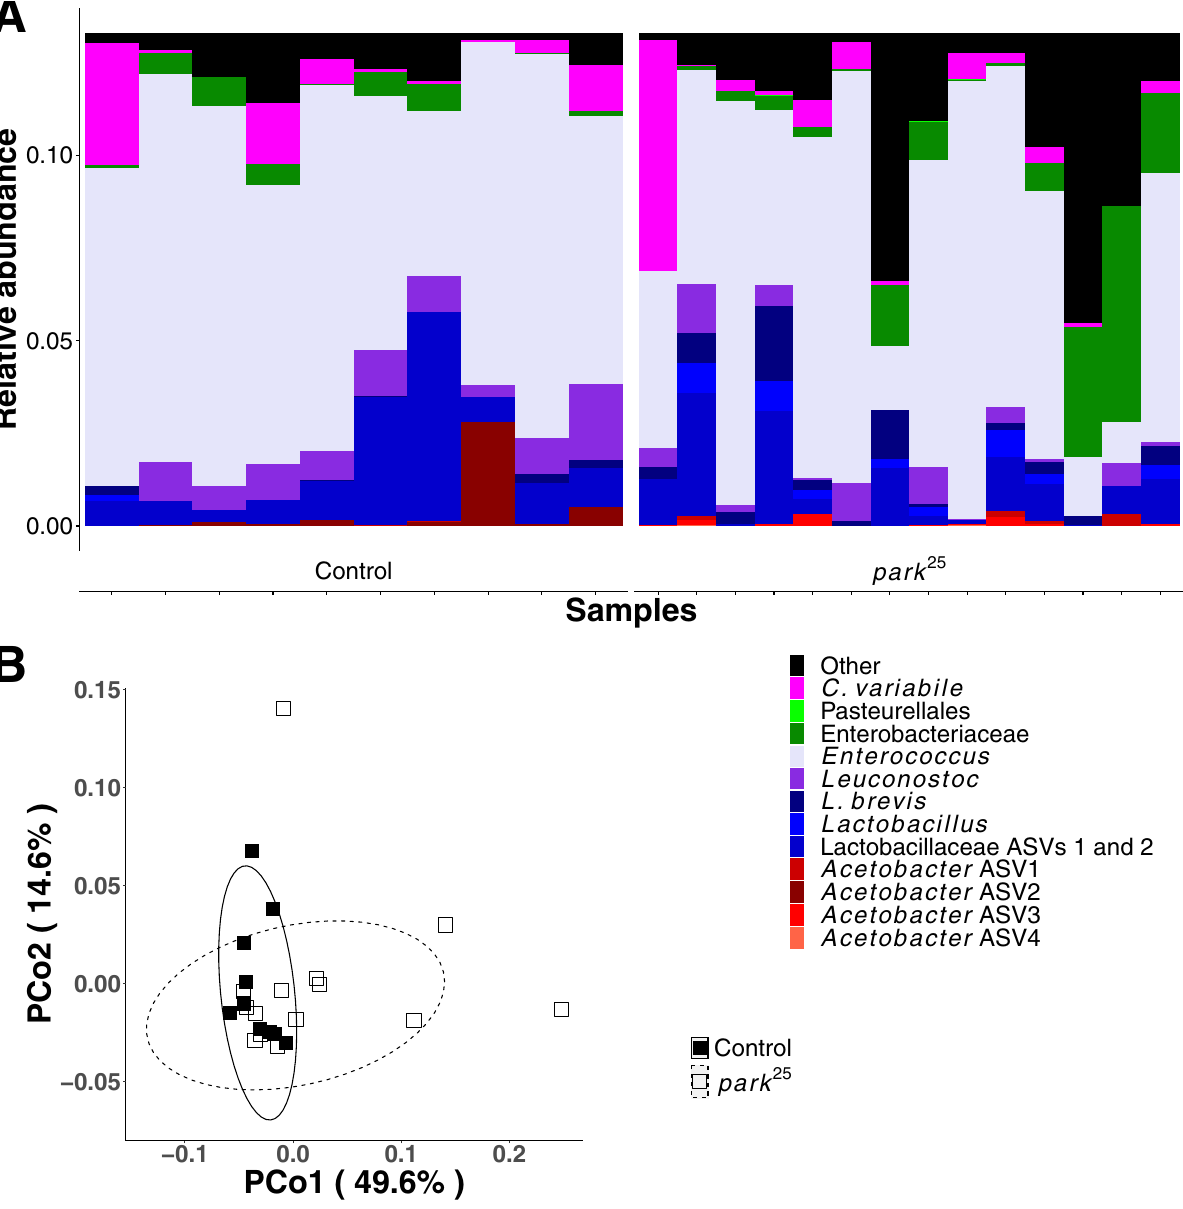
Figure 5. The microbiota of feces from control and park 25 flies. Fecal samples were collected from male controls and a mixture of heterozygous and homozygous male park 25 flies. ( A ) A taxon plot with bars representing distinct ASVs. The legendshows the lowest taxonomic level that was assigned to each ASV. ( B ) Principal coordinates plot, showing the first two coordinates calculated from a weighted Unifrac distance